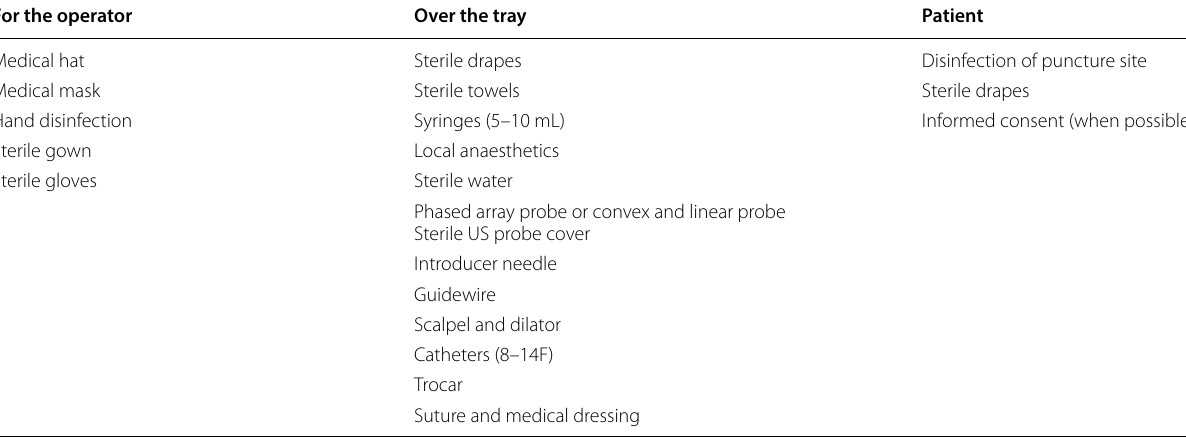
US ultrasound, F French (1F